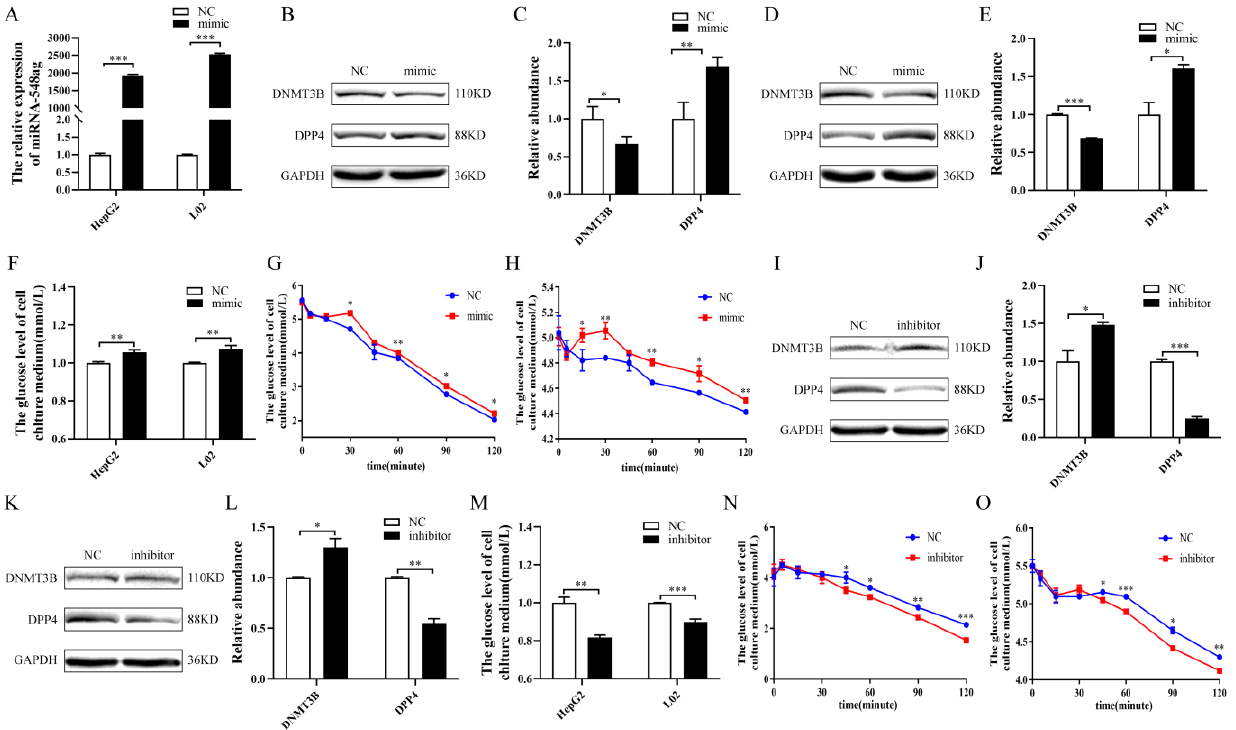
Figure 3. Effect of miR-548ag on the expressions of DNMT3B and DPP4. ( A ) The expression of miR-548ag in HepG2 and L02 cells was upregulated when 50 nM of miR-548ag mimic was used. ( B – E ) The protein expressions of DNMT3B and DPP4 in HepG2 and L02 cells after the overexpression of miR-548ag. ( F ) The glucose consumption, ( G , H ) insulin sensitivity, and ( I – L ) protein expressions of DNMT3B and DPP4 in HepG2 and L02 cells after transfection with 100 nM miR-548ag inhibitor for 24 h. ( M ) Glucose consumption after the inhibition of miR-548ag. ( N , O ) Insulin sensitivity after the inhibition of miR-548ag. (The p -values obtained in the t -test and non-parametric rank sum test are indicated. The data are presented as mean ± SEM. * p < 0.05, ** p < 0.01, and *** p < 0.001 indicate a significant difference).